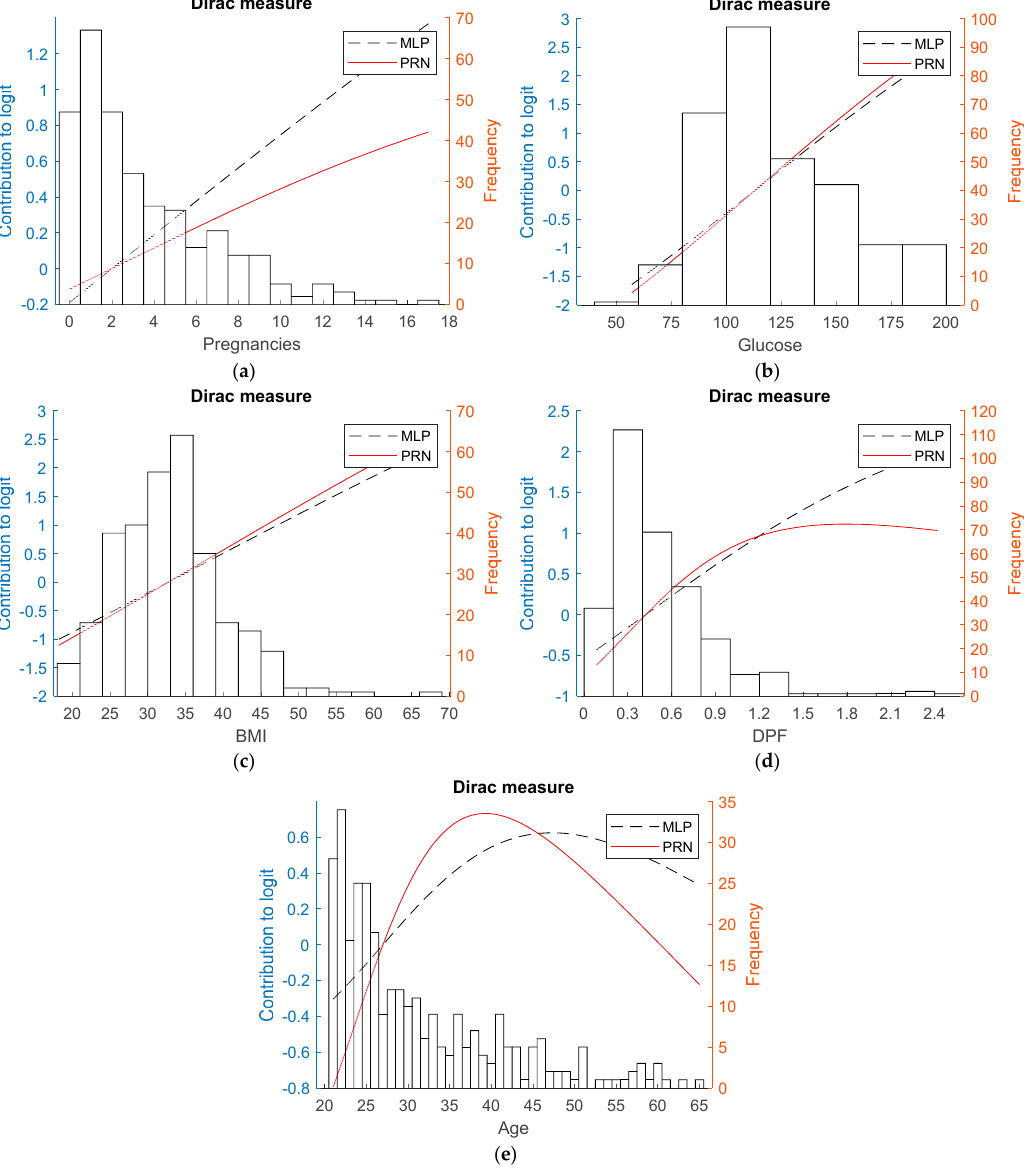
Figure 6. Contributions to the logit from partial responses to the logit (left axis) for the Diabetes data set, obtained with the Dirac measure, overlapped with the histogram of the training data (right axis). The final partial responses derived at the second application gradient descent (solid lines) are shown alongside the partial responses from the original MLP (dashed lines). Five covariates are represented, namely ( a ) Pregnancies, ( b ) Glucose, ( c ) BMI, ( d ) DPF and ( e ) Age.